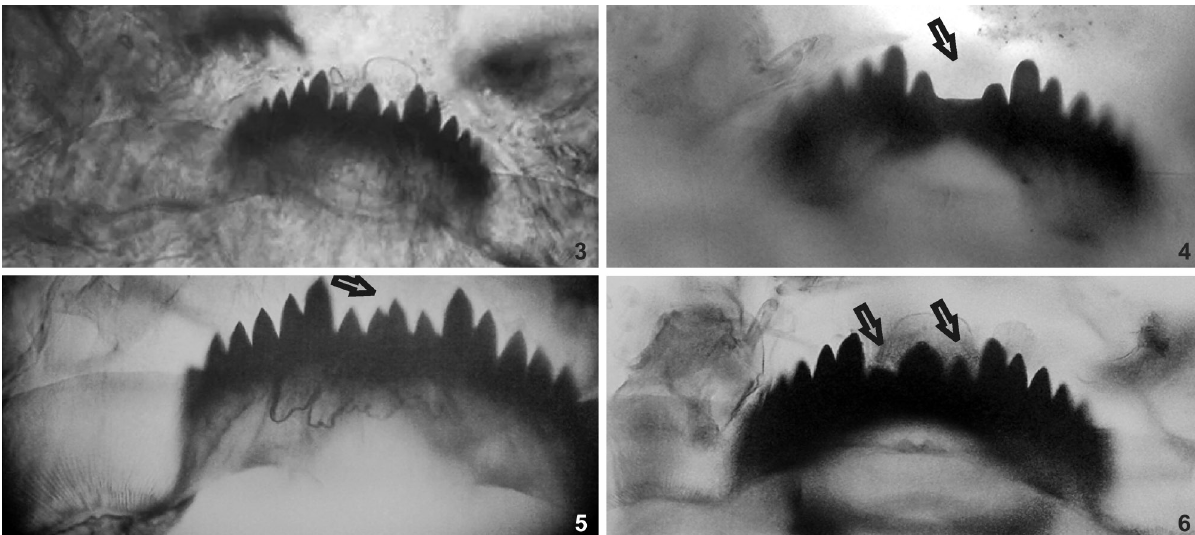
Figures 3–6. Deformities in the mentum of Chironomus (oral cavity): (3) standard mentum; (4) deformed mentum (deletion of teeth); (5) deformed mentum (addition of teeth); (6) deformed mentum (tooth